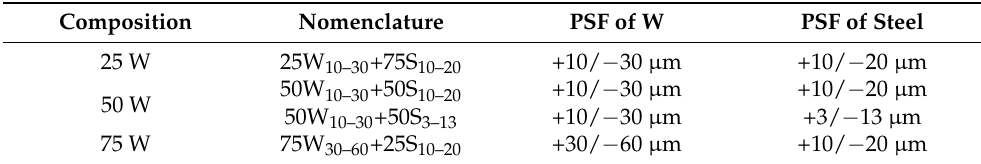
Table 1. PSF of the W and steel powders for different